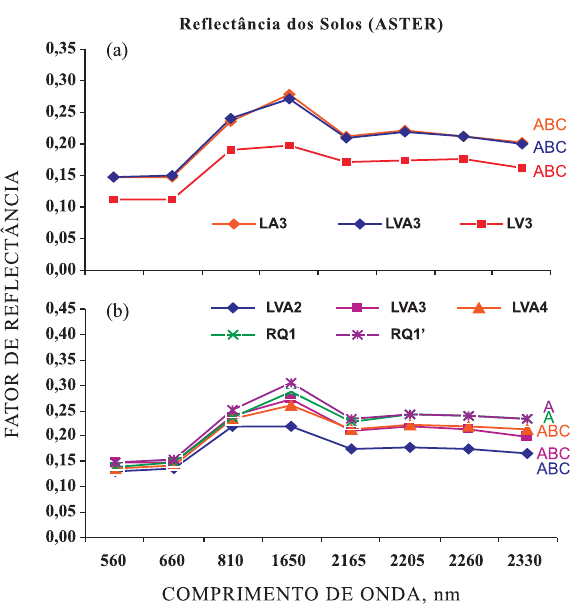
Figura 5. Reflectância de diferentes subordens de Latossolos com classes texturais semelhantes (a) e de mesmas subordens de solos, porém com diferentes texturas (b), obtidas pelo sensor ASTER para amostras da camada superficial. Mesma letra não difere significativamente a 5 % pelo teste de Tukey para a banda de 2.260